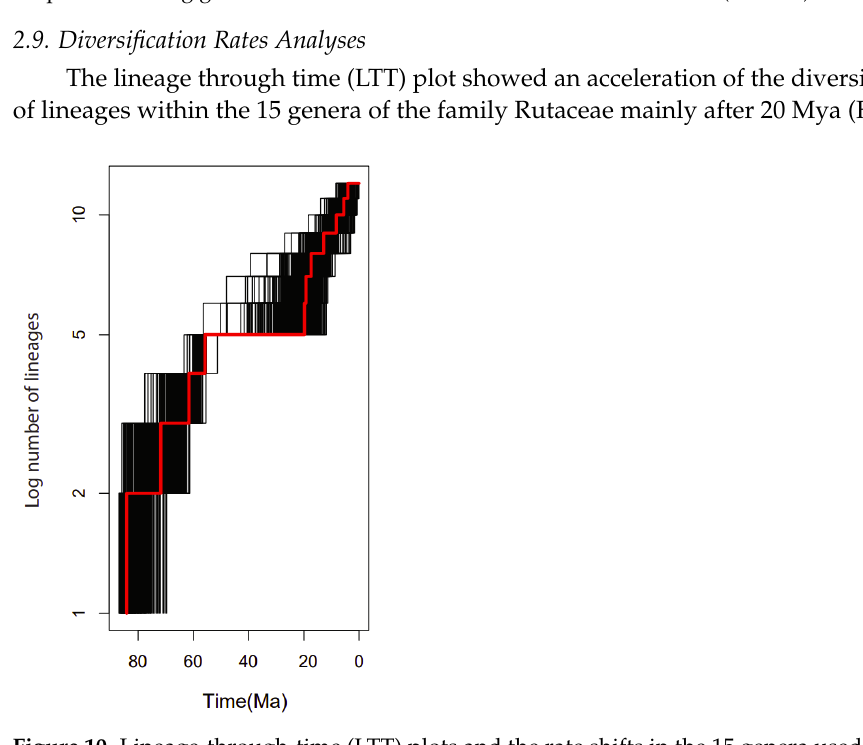
Figure 9. Phylogenetic chronogram showing the evolutionary dating time taxa of the 15 genera in the family Rutaceae and two outgroups. The tree was estimated using Bayesian analysis of 79 protein-coding genes and 35 taxa in the Markov Chain Monte Carlo (MCMC) tree.